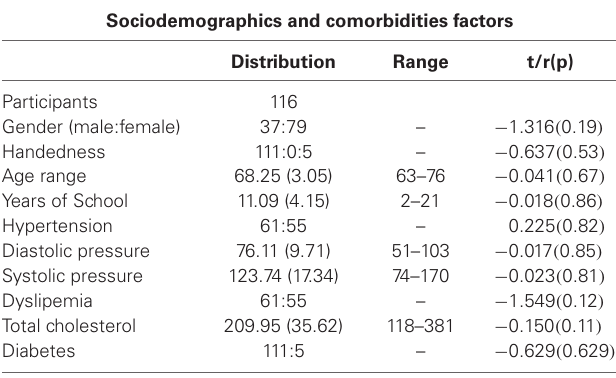
Table 2 | Sociodemographic characteristics and comorbidities factors